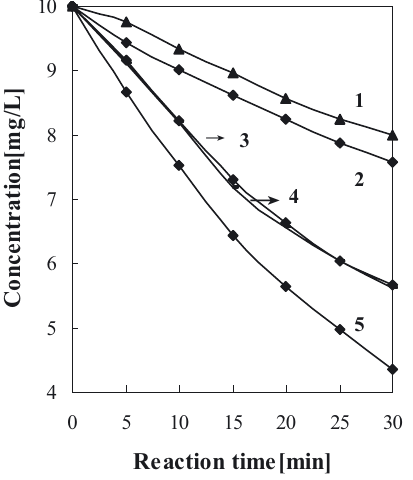
Figure 9. The promotion effect of - lytic decolorization; (1)